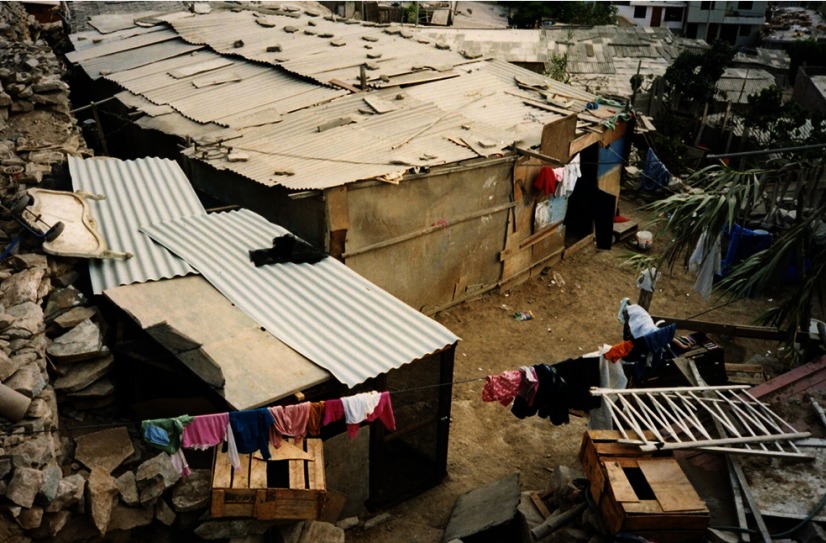
Contrast Between Human and Animal Living Spaces Documented Through Observation, Las Pampas de San Juan de Miraflores, PeruProject-constructed poultry corral (left foreground) vs. human habitation (center background). Project participants sometimes joked that the birds in the project enjoyed a better standard of living than the people. © 1999 Steven Harvey.